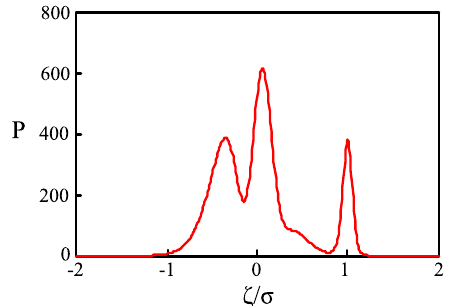
FIG. 7. Radiation pulse shape along the bunch coordinate in the case of three current density regions in the starting electron beam. In this example the first two bunches have the same parameters described in Fig. 6(b) while the last added one has a distance δζ ≅ σ from the center at ζ ¼ 0 , with μ 0 . 09 and σ ≅ σ = 8 . ε ; 3 ¼ 3 FIG. 8. Comparison between the simulation (dashed magenta line) and experimental FROG data (blue continuous line) for the shape of the radiation pulse. Also the Current distribution of the two electron beamlets is shown as pulse 1 and 2 together with the laser shape (not in scale). The amplitude is in arbitrary units.